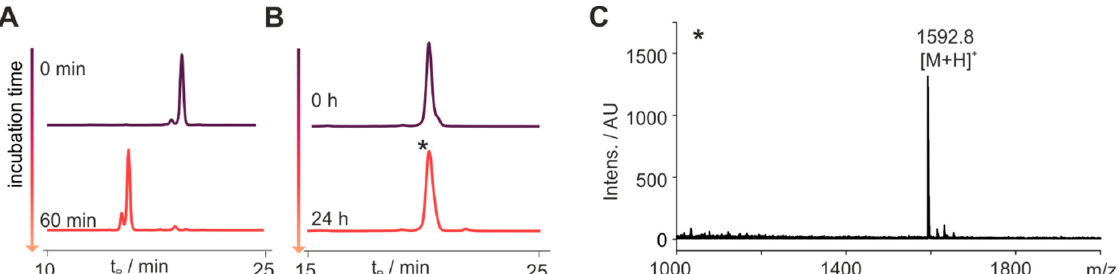
Figure 3. N-Terminal modification is essential for metabolic stability. ( A ) Bearing a free N-terminus, the cyclic peptide 7T is fully degraded after 60 min. ( B ) Introducing a D-Tyr in position 1 yields the metabolically stable peptide 8T , which is not degraded for 24 h in blood plasma. RP-HPLC traces of samples are displayed taken at the indicated time points detecting the fluorescence at λ em = 573 nm. ( C ) Mass spectrometrical analysis of the peak indicated by an asterisk (*) confirmed the integrity of the peptide 8T after 24 h through its (M + H) + signal at m / z = 1592.8 (M mono = 1591.6).